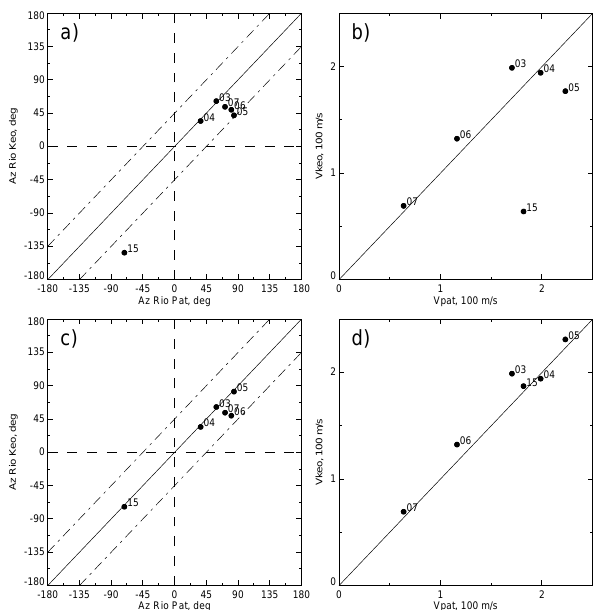
Fig. 11. Comparison of the (a) azimuths and (b) speeds of the patch drift motion on 14 February 2001 as determined from absorption keograms and images. The digits by each point indicate the patch number, Figs. 1, 2e. Panels (c) and (d) show the same comparison but with the assumed additional rotation of the velocity vector for points 05 and